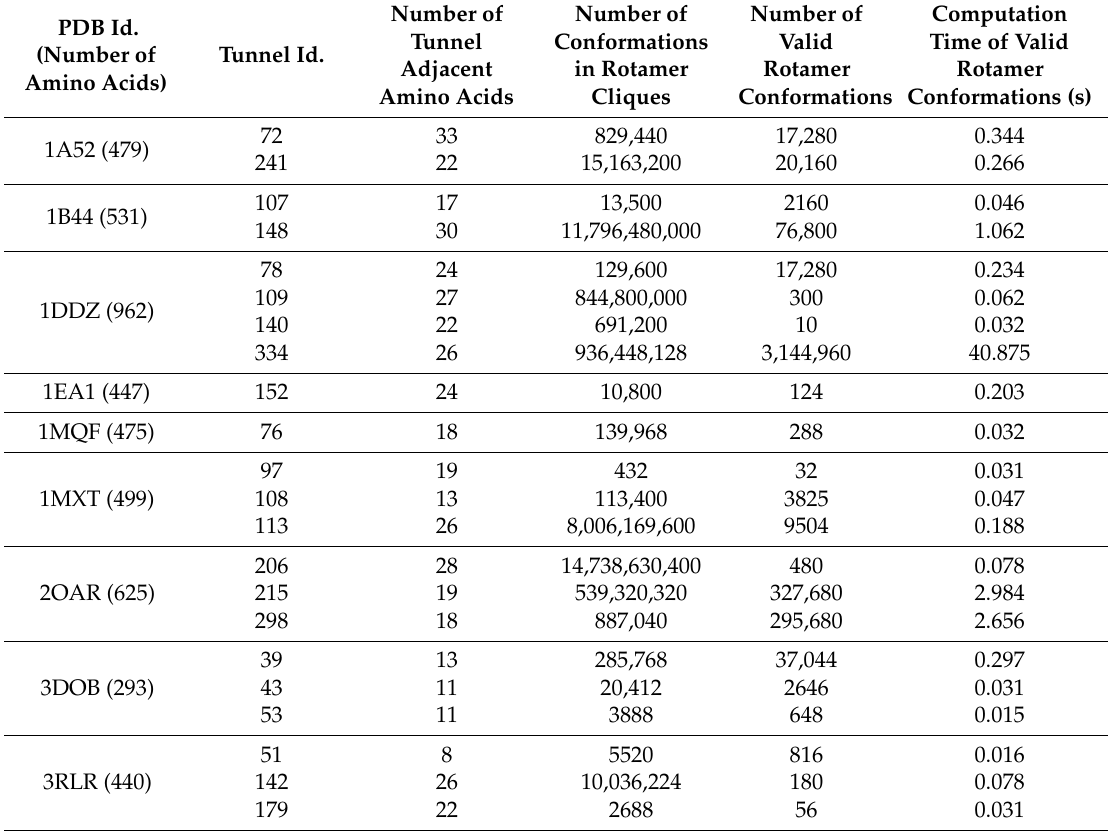
Table 1. Experimental Results on Finding Valid Rotamer